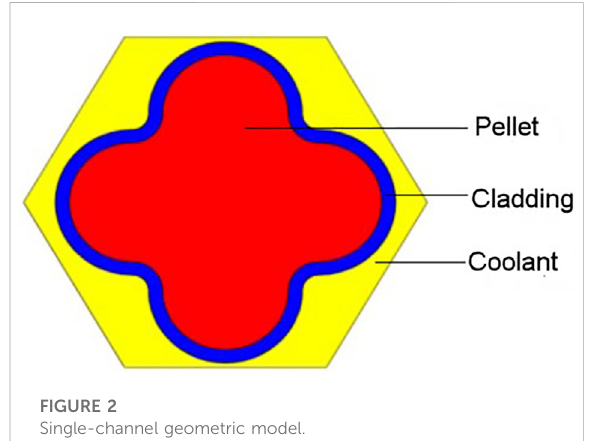
FIGURE 2 Single-channel geometric